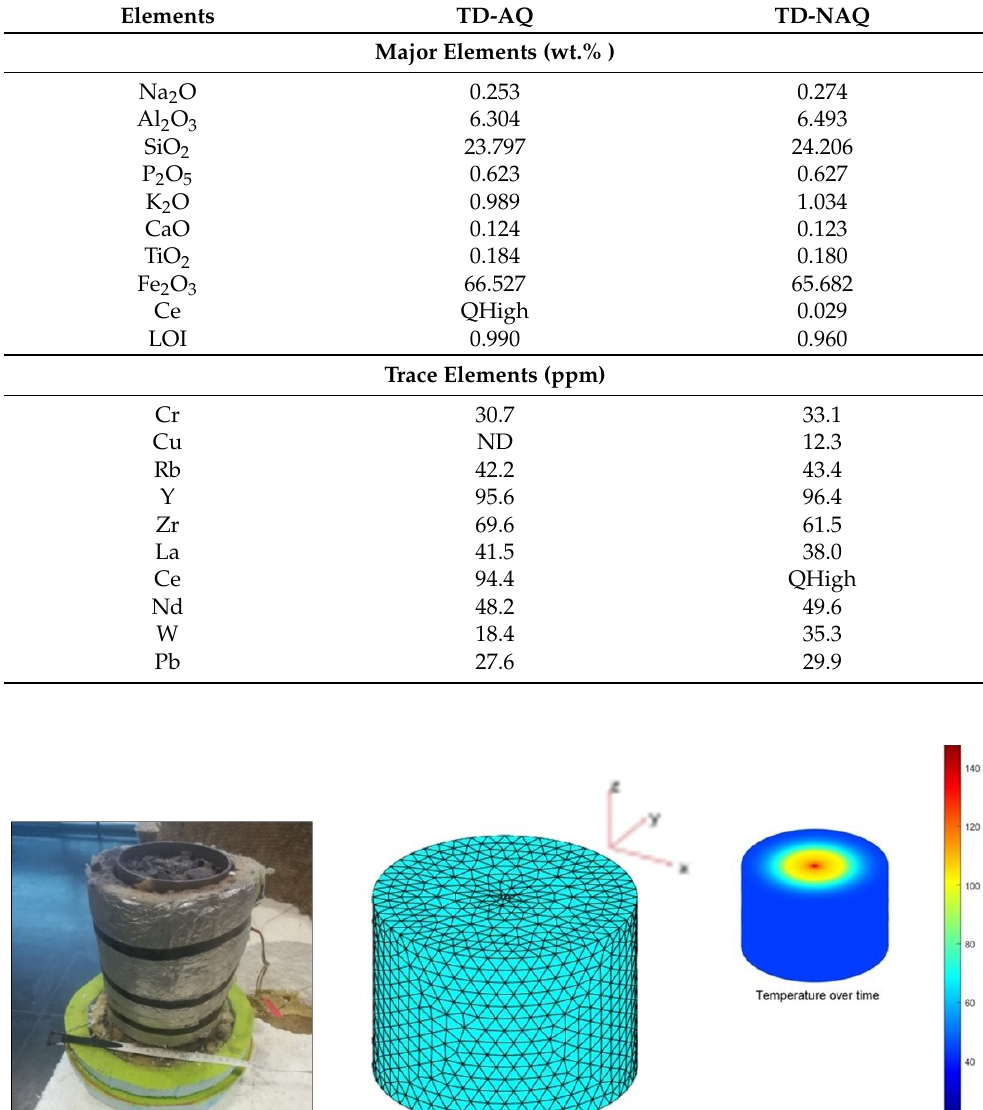
Table 2. XRF analysis of TD-AQ and TD-NAQ lots, illustrating the major and trace elements in wt.% and ppm, respectively.